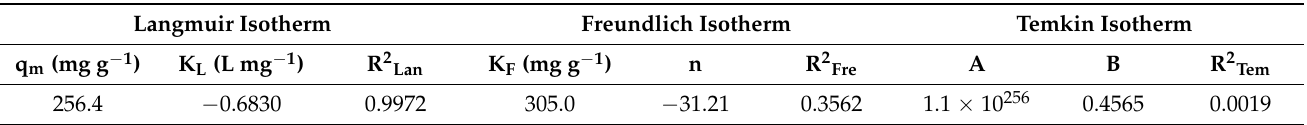
Table 2. Parameters calculated for Cd(II) adsorption over CNTs-Ag 2 S using Langmuir, Freundlich, and Temkin adsorption isotherm